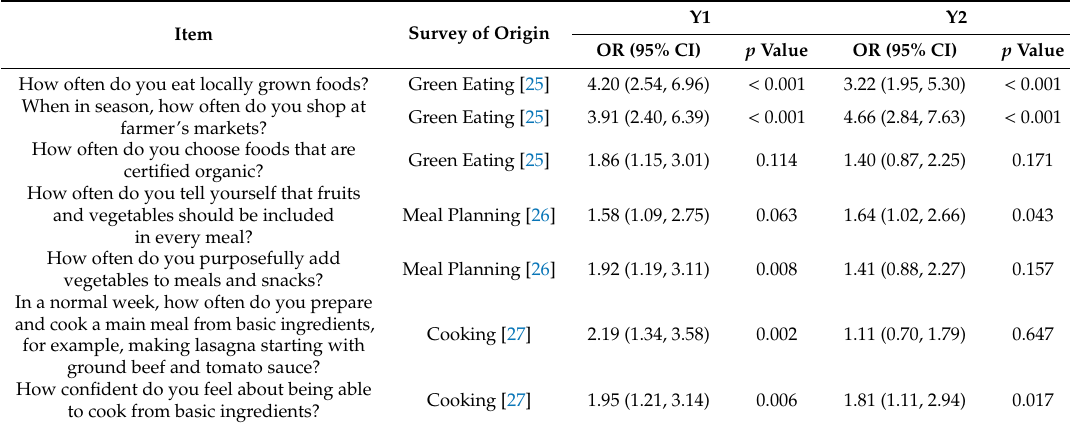
Table 3. FV-related attitudes and behaviors among Y1 + Y2 Gardeners.